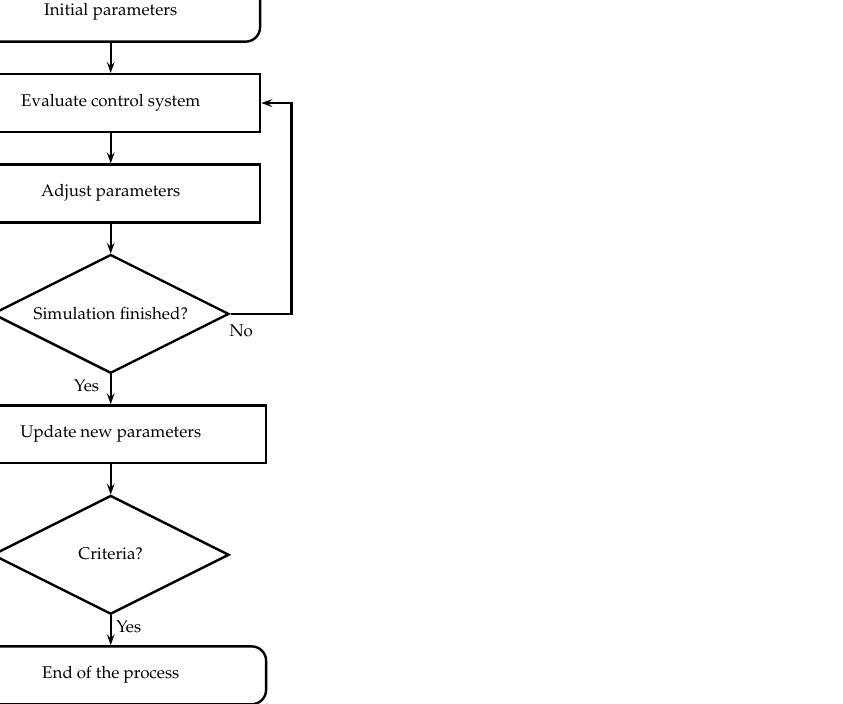
Figure 13. Algorithm for controller